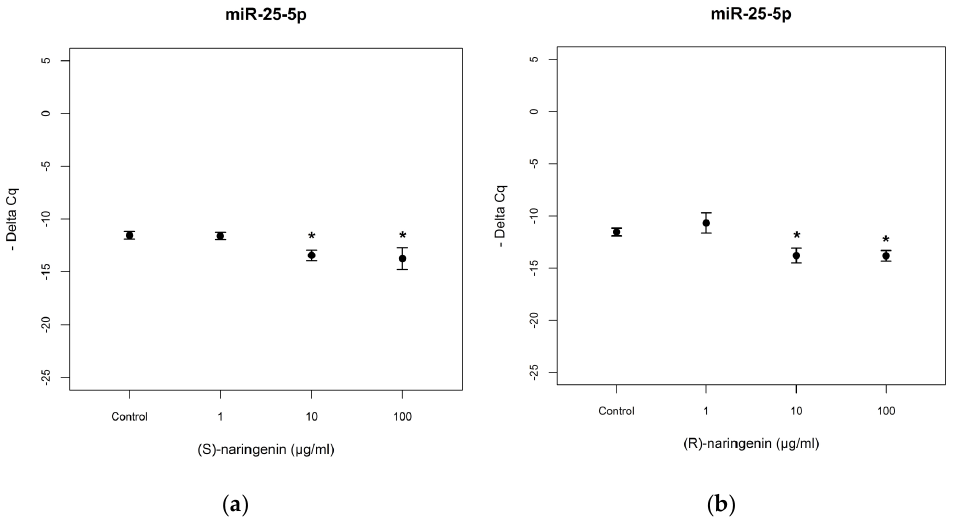
Figure 5. Expression levels, reported as Delta Cq, of miR ‐ 25 ‐ 5p in Caco ‐ 2 cells treated with increasing concentrations of ( a ) ( S ), and ( b ) ( R ) naringenin enantiomers (1–100 μ g/mL). * Indicates statistically significant differences between treated and untreated cell cultures, as reported in the text.